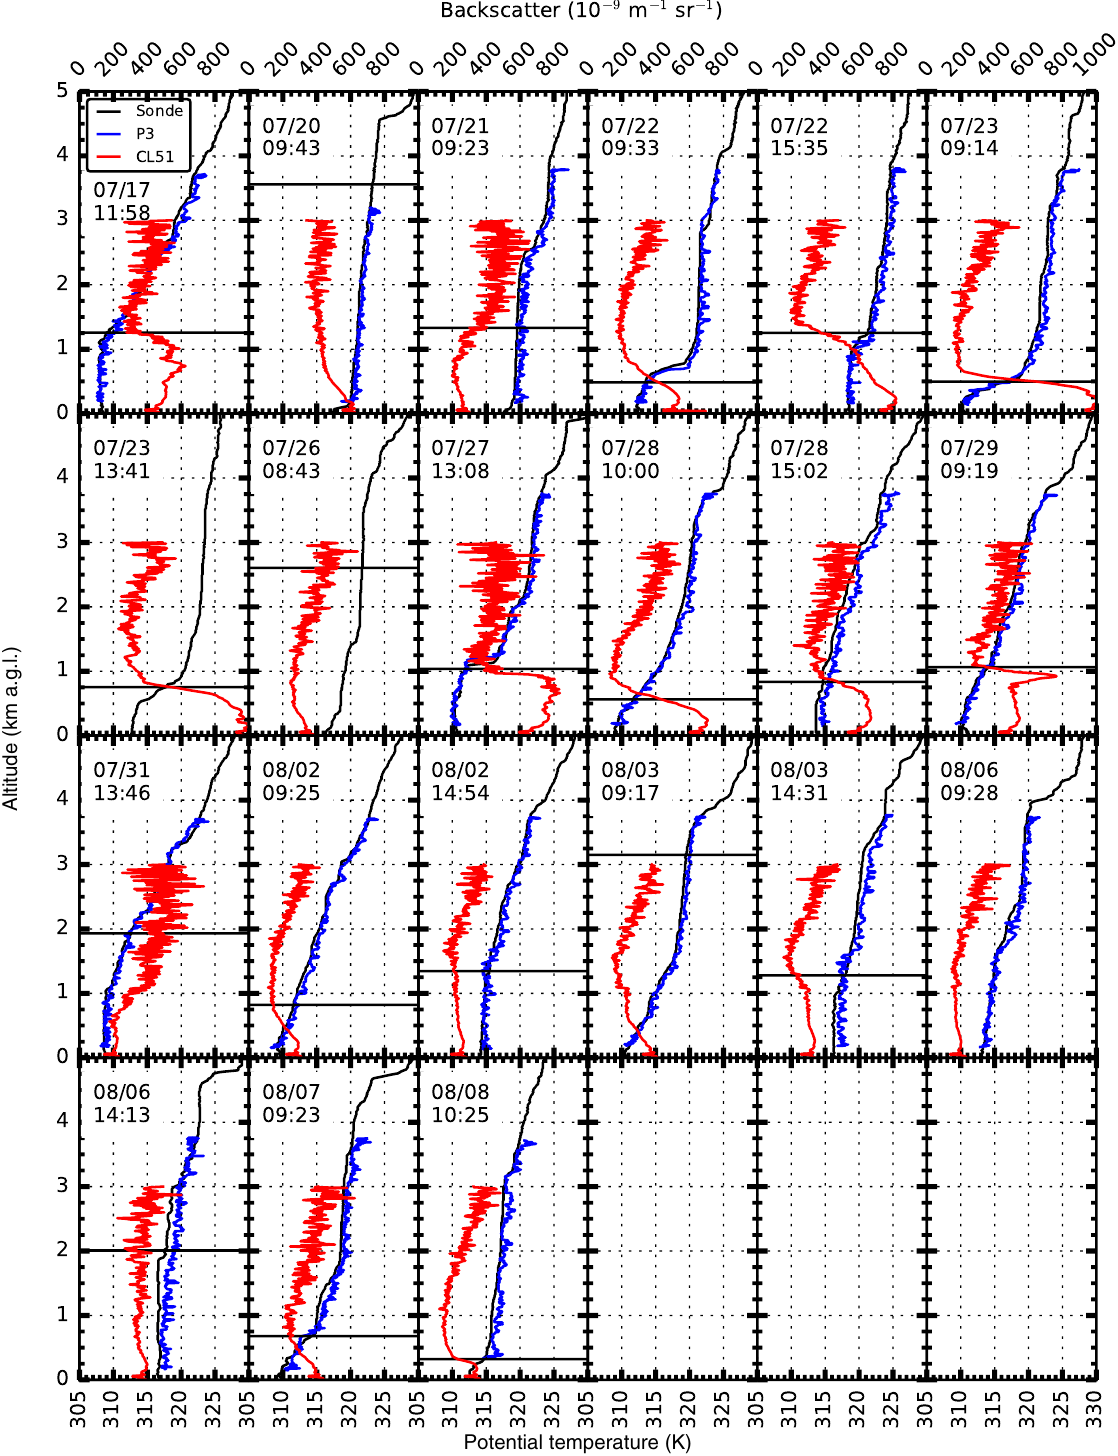
Figure 13. Potential temperature and Cl51 backscatter profiles collected at the Golden NREL site. Horizontal lines indicate MLH as deter- mined by